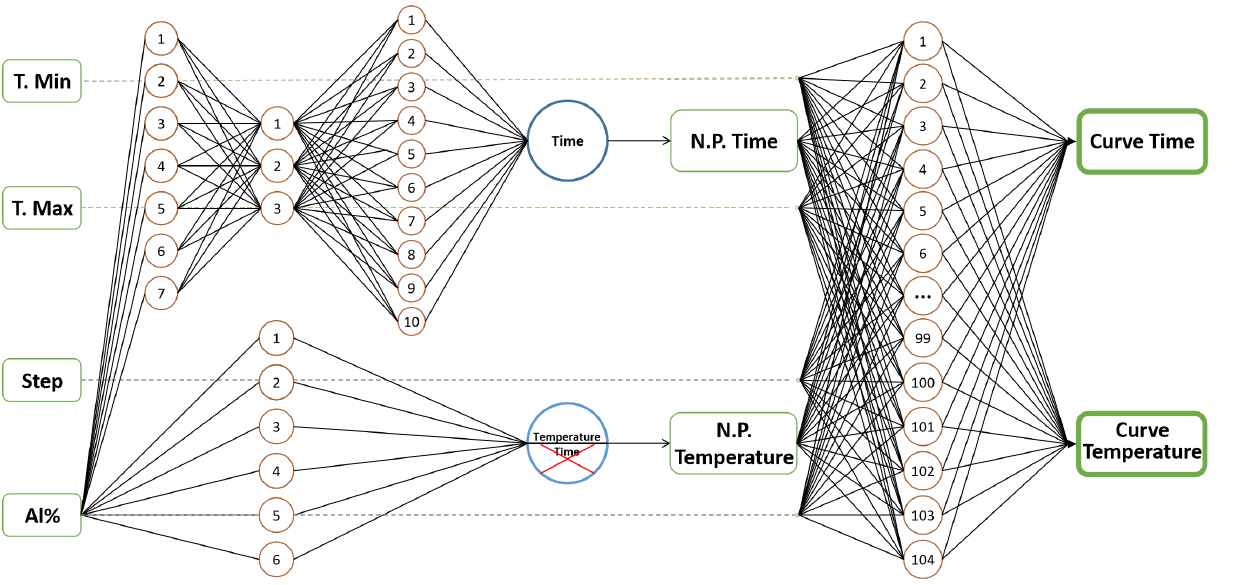
Figure 5. PredictionScheme of the proposed hybrid network. The model receives four inputs for the prediction of the nose point, the top and bottom of the TTT diagram.